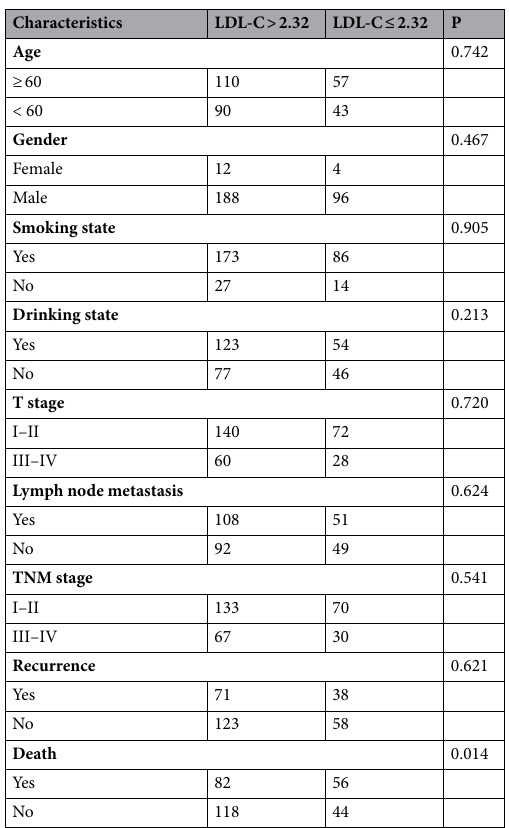
Table 5. Relationship between LDL-C concentration and clinical characteristics in 300 Patients With squamous cell carcinoma of lung based on chi-square